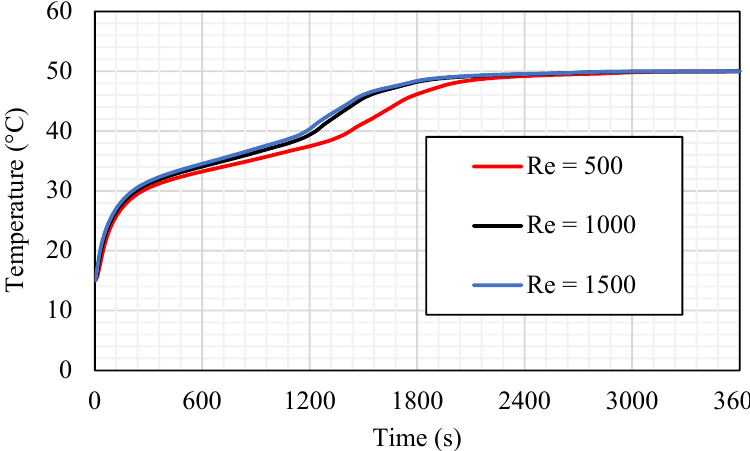
Figure 16. The average temperature profile for the total PCM for the case of 3b (Tin equals 50 °C) at different values of Re (500, 1000, and 1500). Table 3. Melting time until achieving 95% and the heat-transfer rate in 1800 s for the cases of Re equals 500, 1000, and 1500.